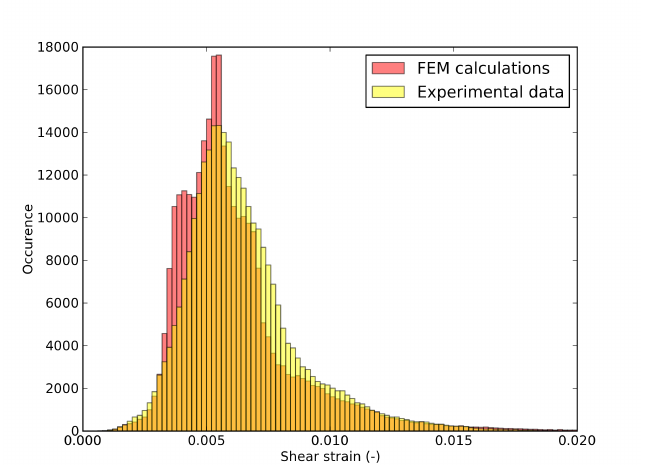
Figure 13. Probability distribution of shear strain at the last pre-peak step in the whole domain Ω , comparing FEM calculation (verification step) and experimental